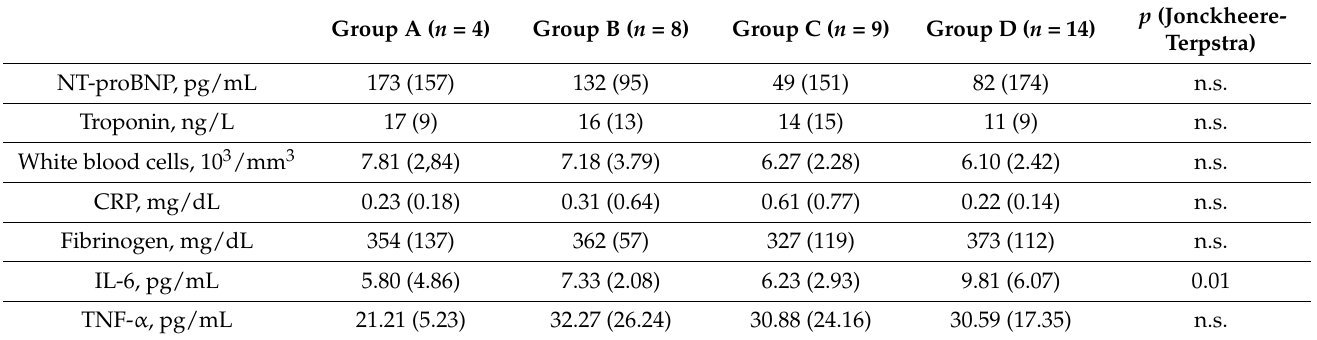
Table 2. Cardiac and inflammatory markers among the four groups (median (interquartile